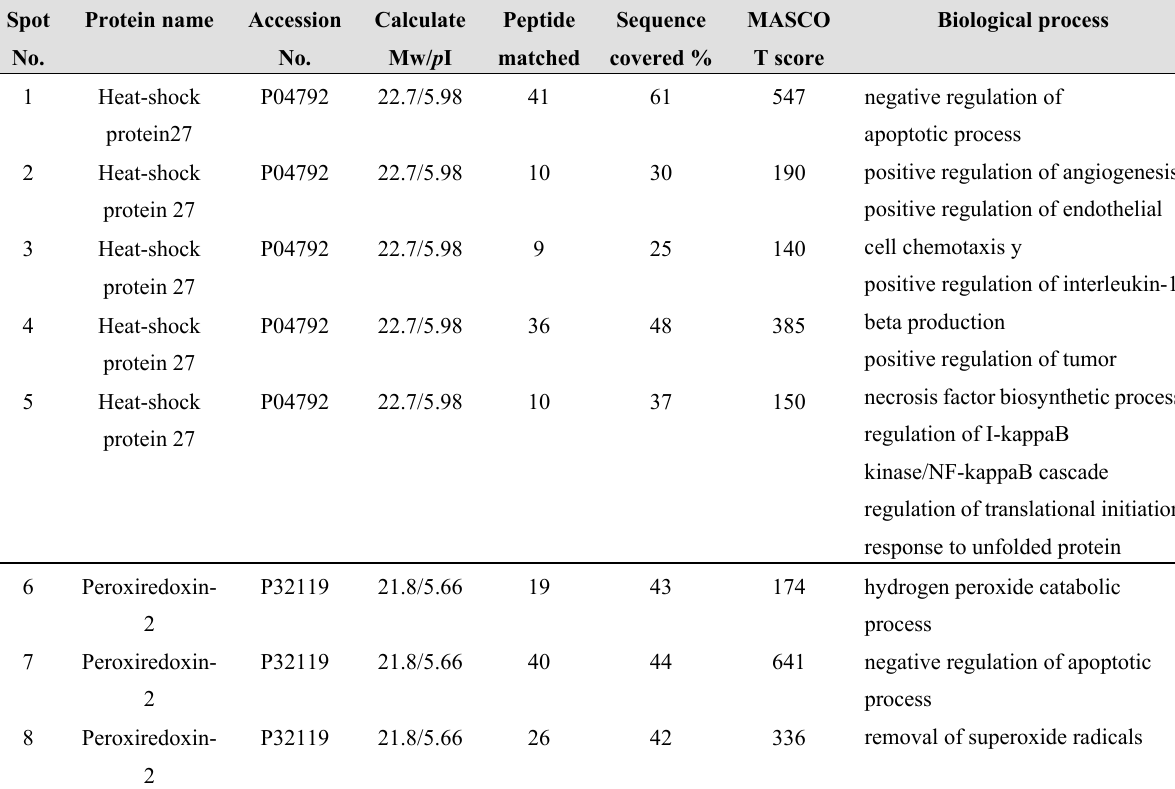
Table 1. Summary of differential proteins identified by LC-MS/MS